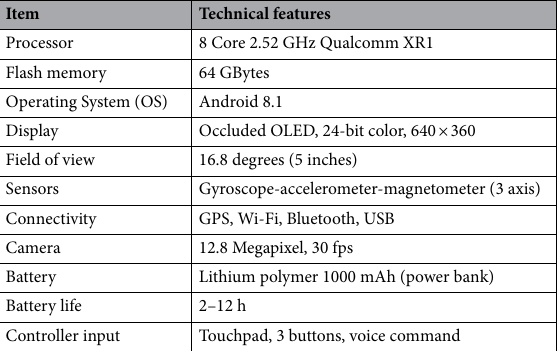
Table 1. Main technical specifications of Vuzix M400 Smart Glasses (as reported by the company).